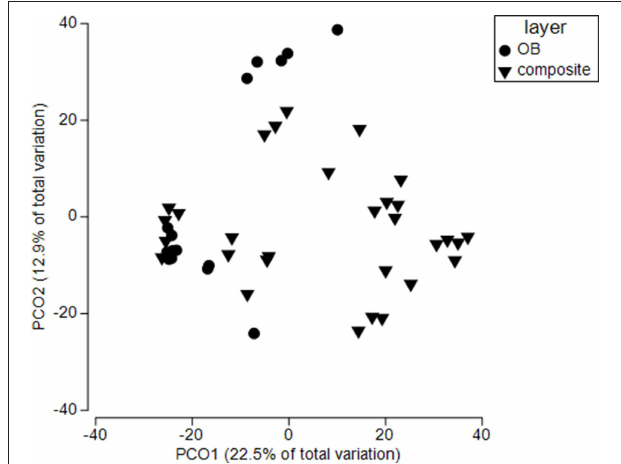
FIGURE 7 | Principle coordinate analysis for soils in sites receiving both standard topsoil transfer and overburden (OB). Each symbol represents the fungal community within a single soil core. Ref refers to an adjacent, undisturbed site. All sites are significantly different from each other ( p < 0.0001), but sites responded differently to overburden treatment (site X overburden, p < 0.05). See Table S2 for more details.